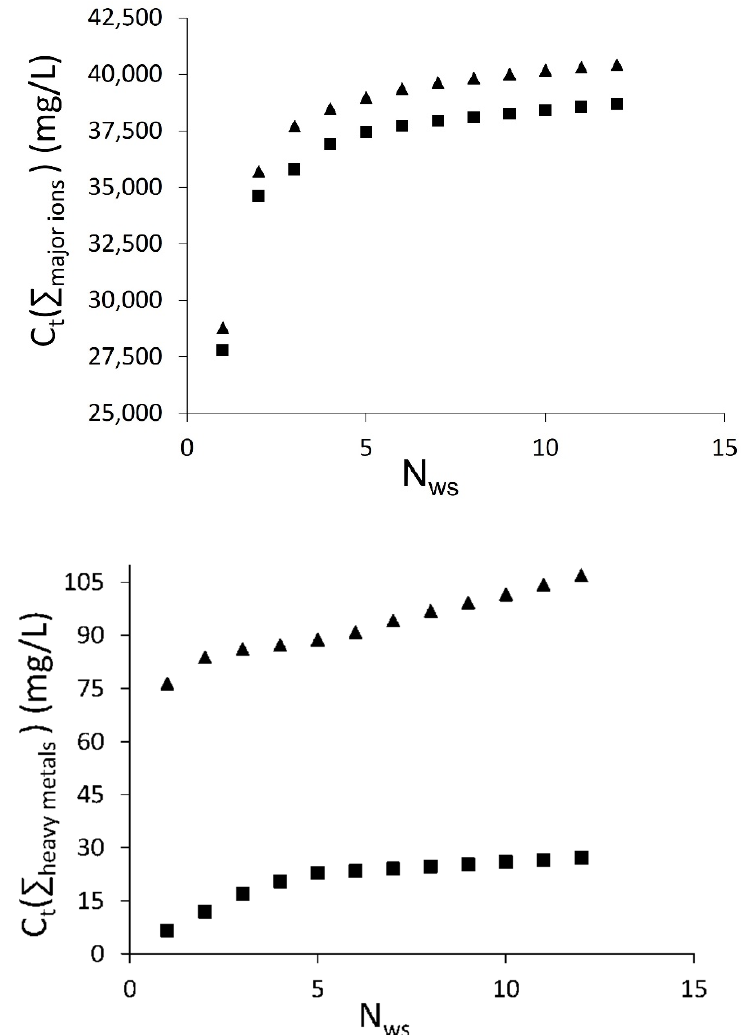
Figure 3. Cumulative leaching concentration (C t ) Σ major ions , top, and Σ heavy metals , bottom, versus number of washing steps (N ws ) at 25 (squares) and 80 °C (triangles).